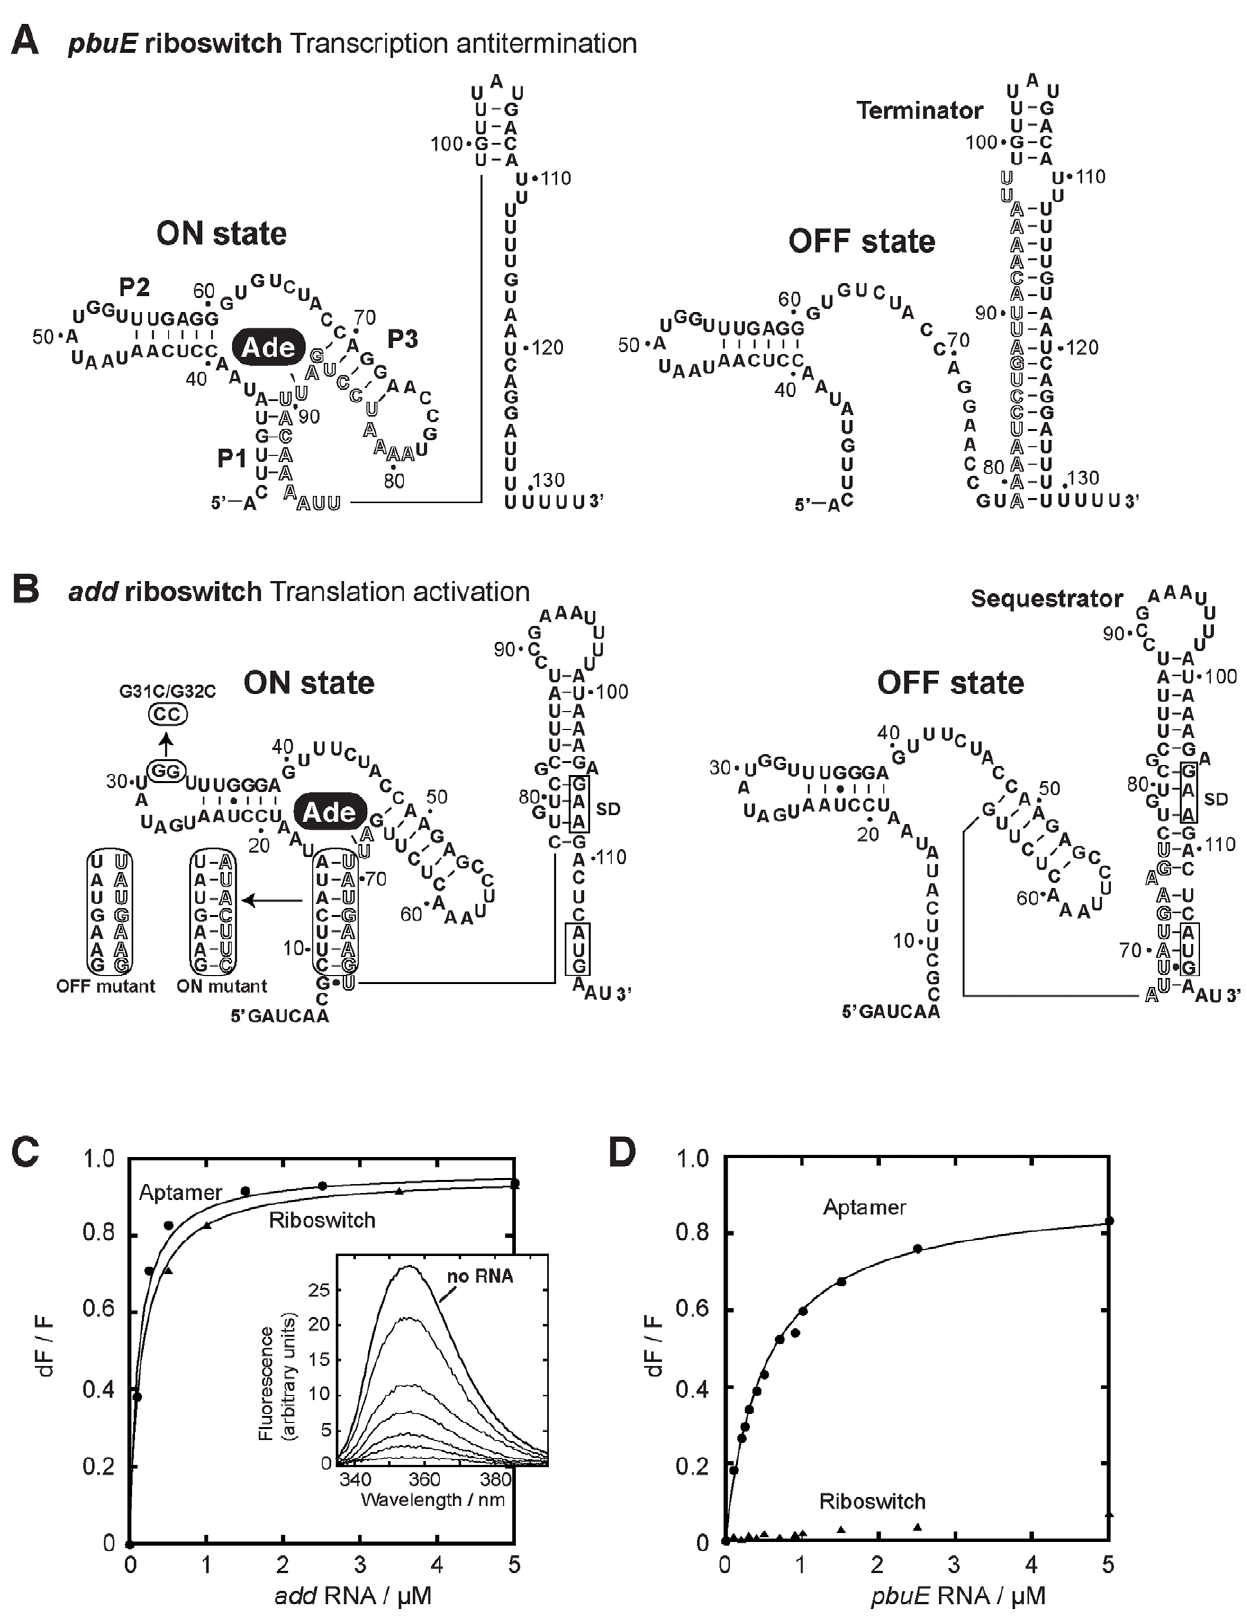
Figure 1. pbuE and add adenine riboswitches exhibit different ligand binding properties. (A) Secondary structures of the pbuE adenine riboswitch associated with the ON and OFF states. The adenine ligand (Ade) is represented by a black oval. The adoption of the OFF state results in